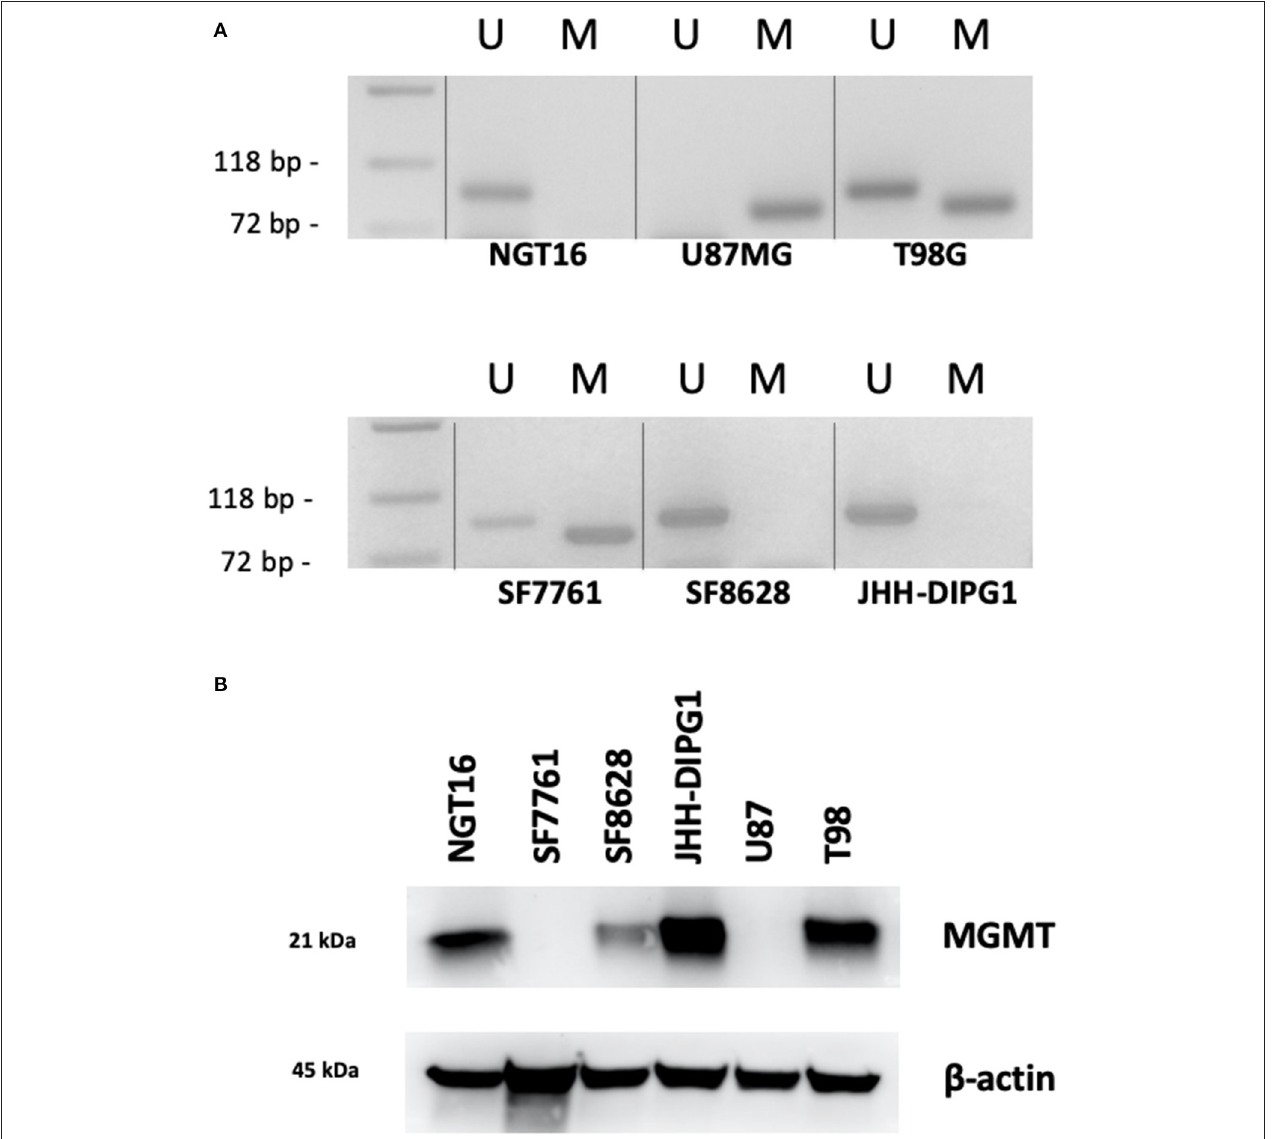
FIGURE 3 | MGMT promoter methylation and MGMT expression in each cell line. (A) Methylation specific PCR (MSP) showed that of the H3K27M diffuse midline glioma (DMG) cell lines, NGT16, SF8628, and JHH-DIPG1 lines had unmethylated MGMT promoter, whereas in SF7761, both bands were seen, but the methylated (M) band was stronger. (B) Western blot shows MGMT expression in NGT16, SF8628, JHH-DIPG1 and T98G, but no expression in SF7761 and U87MG cell lines, consistent with results of MSP.